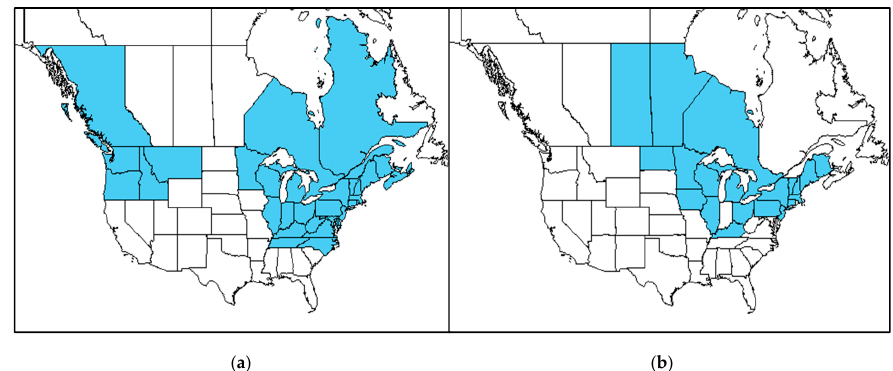
Figure 1. Distribution (filled regions) of naturalized ( a ) Norway maple and Amur maple ( b ) from the USDA PLANTS database https: // plants.sc.egov.usda.gov / java /